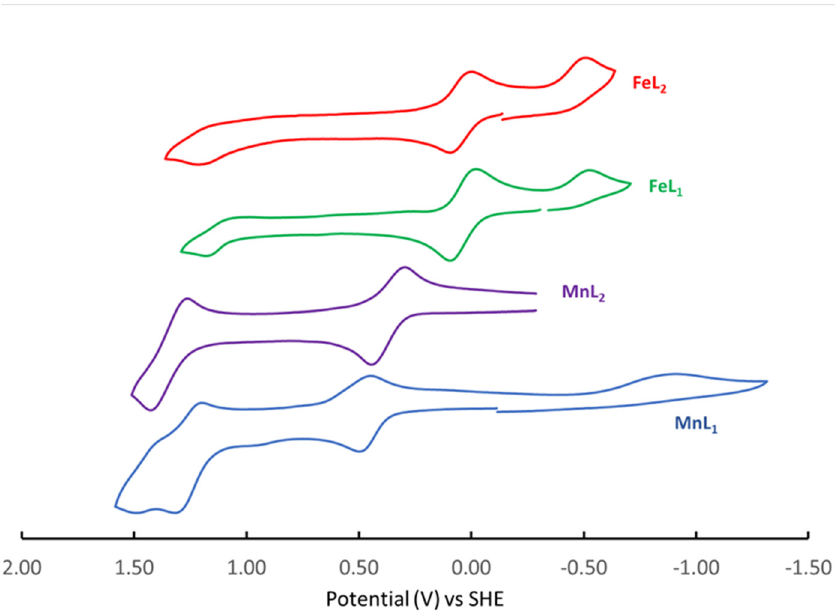
Figure 4. Cyclic voltammograms in acetonitrile with potentials relative to SHE for Mn L 1 (blue), Mn L 2 (purple), FeL 1 (green), and Fe L 2 (red).